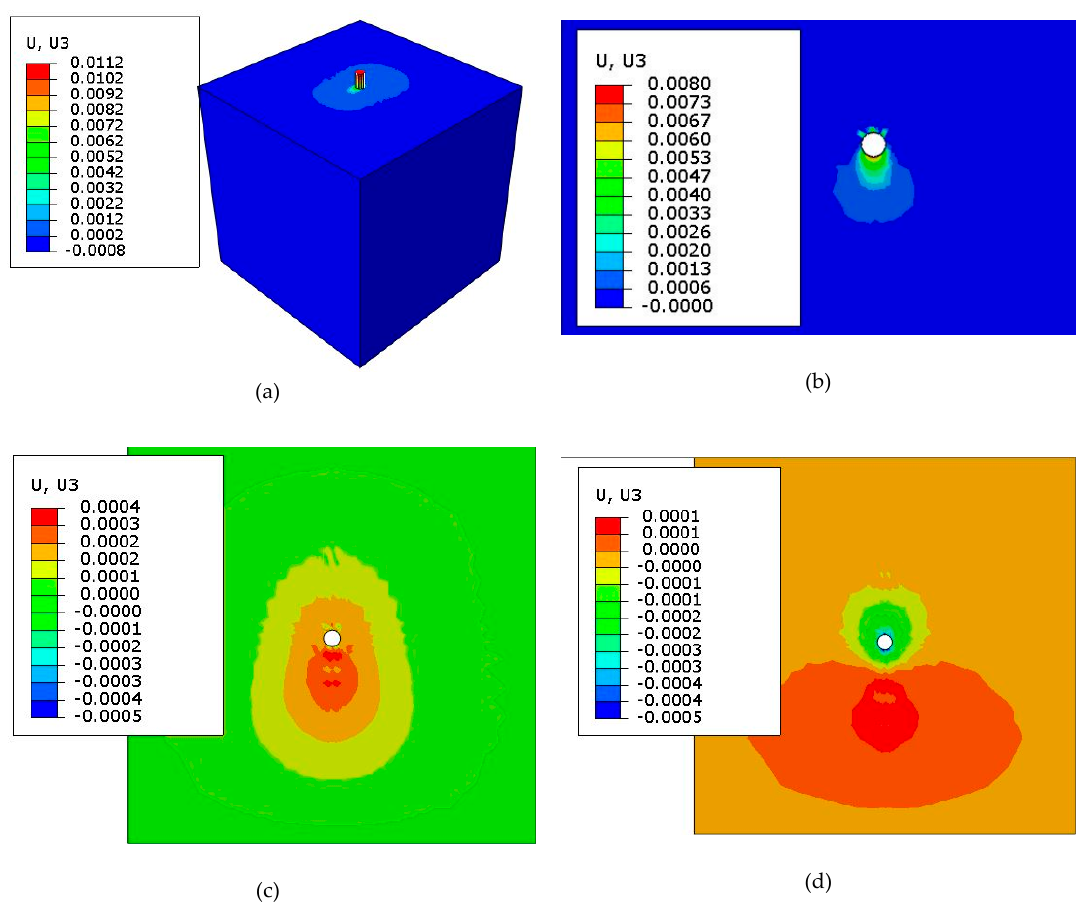
Figure 9. Plan view of Soil deformation at different depth under lateral loading; ( a ) Soil deformation on the lateral load; ( b ) Top of the first layer; ( c ) Top of the Second Layer; ( d ) Top Third Layer.